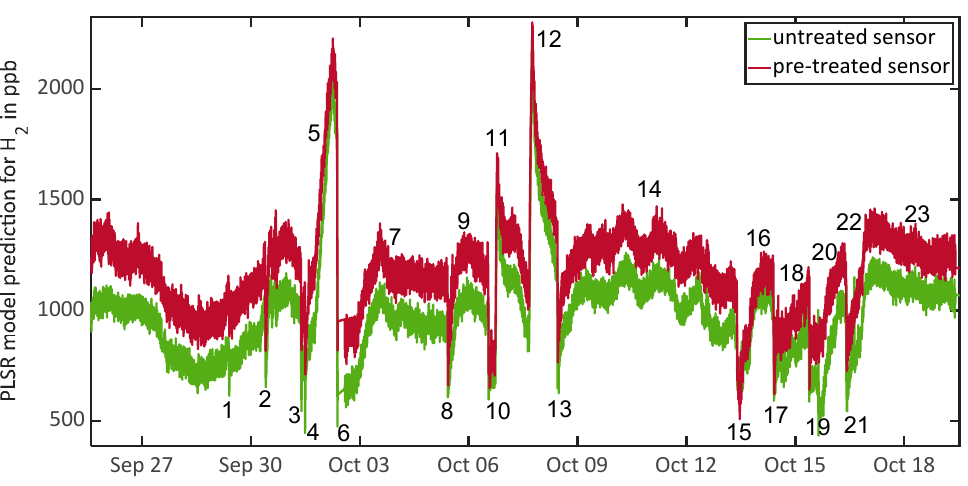
Figure 6. PLSR model predictions for H 2 from both sensors (untreated and pre-treated) over several days. Descriptions of the labelled events and periods can be found in Appendix A, Table A1.